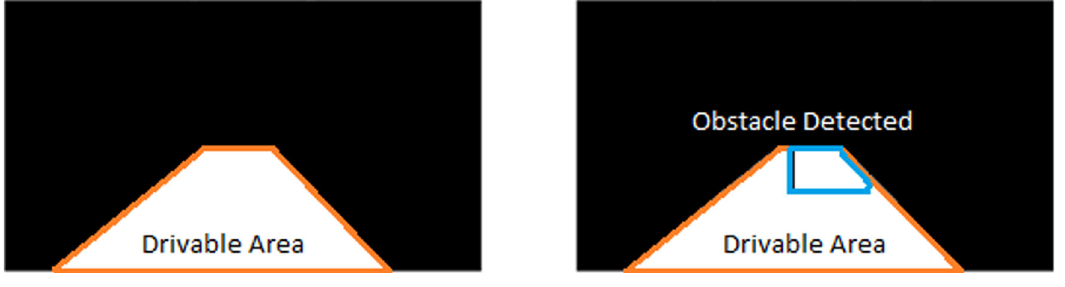
Figure 10. Forward collision warning.